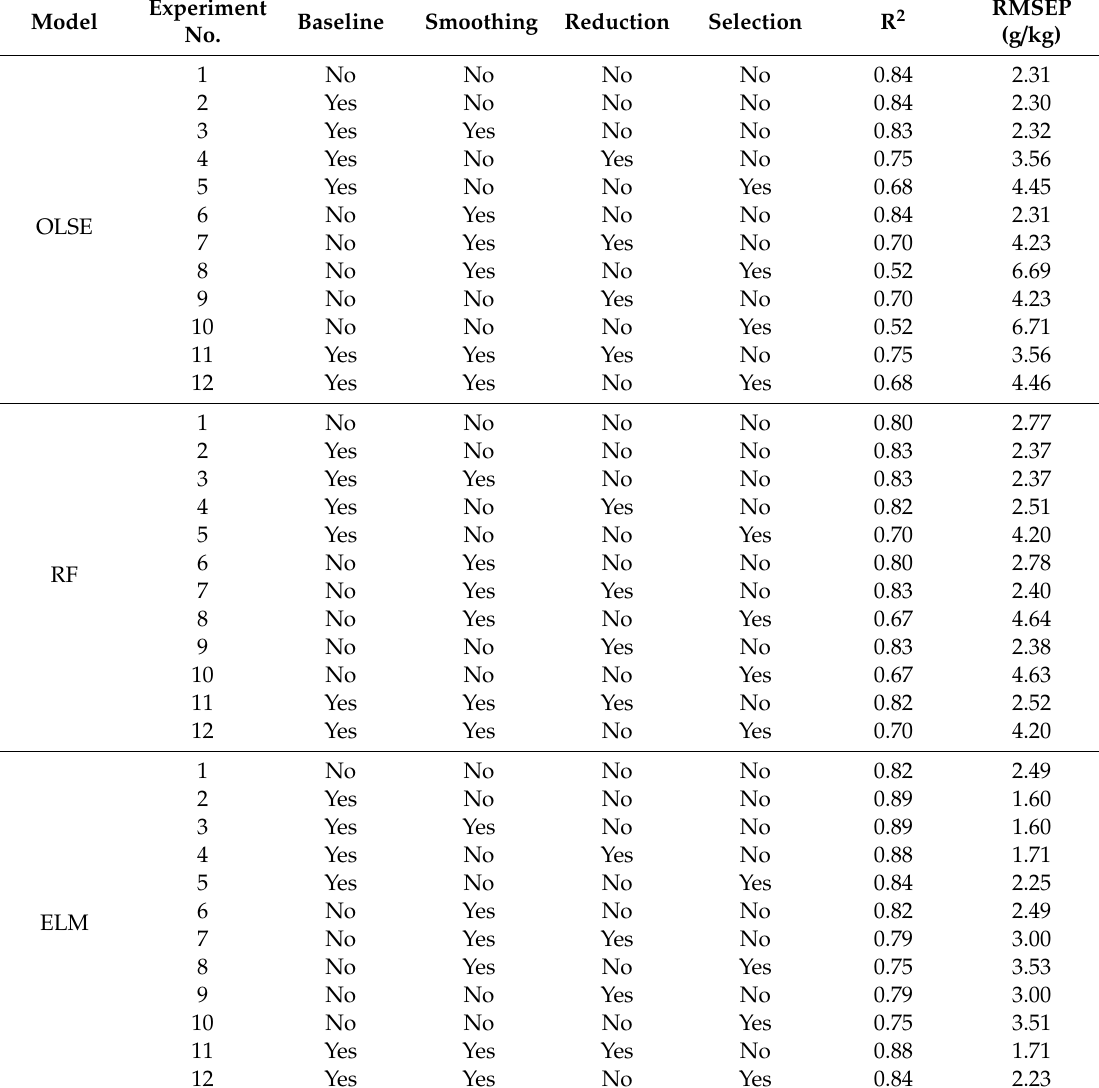
Table 3. The performance of three conventional models based on di ff erent pretreatment methods. Experiment Model No.